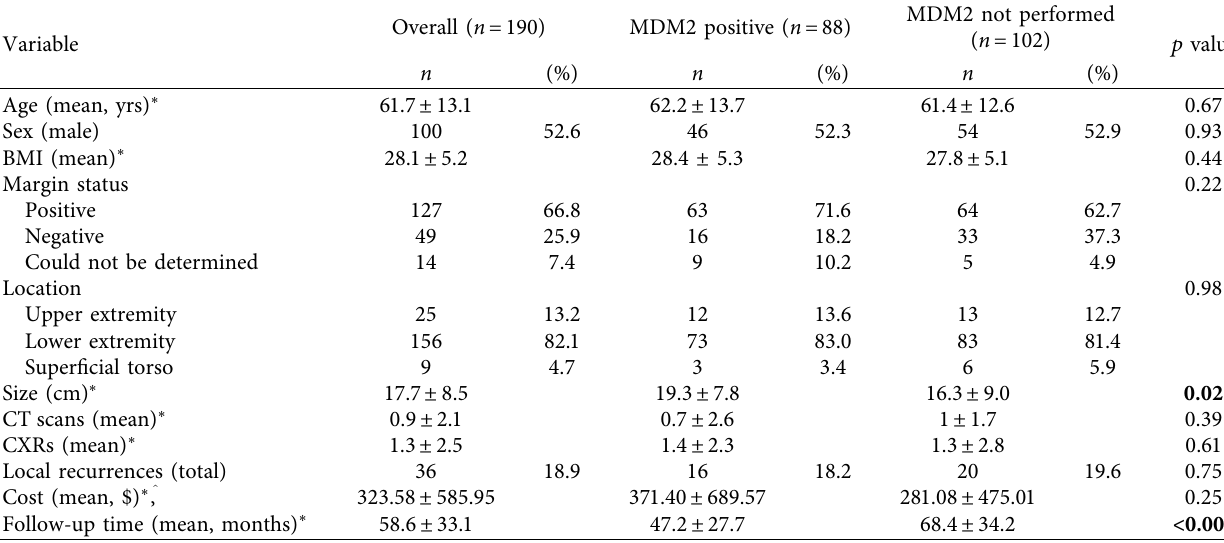
Table 1: Baseline demographic and tumor